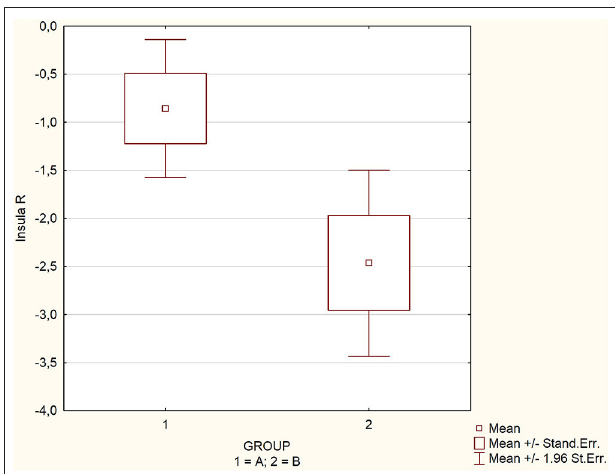
FIGURE 3 | Comparison of perfusion in regions significantly affected by glycemic